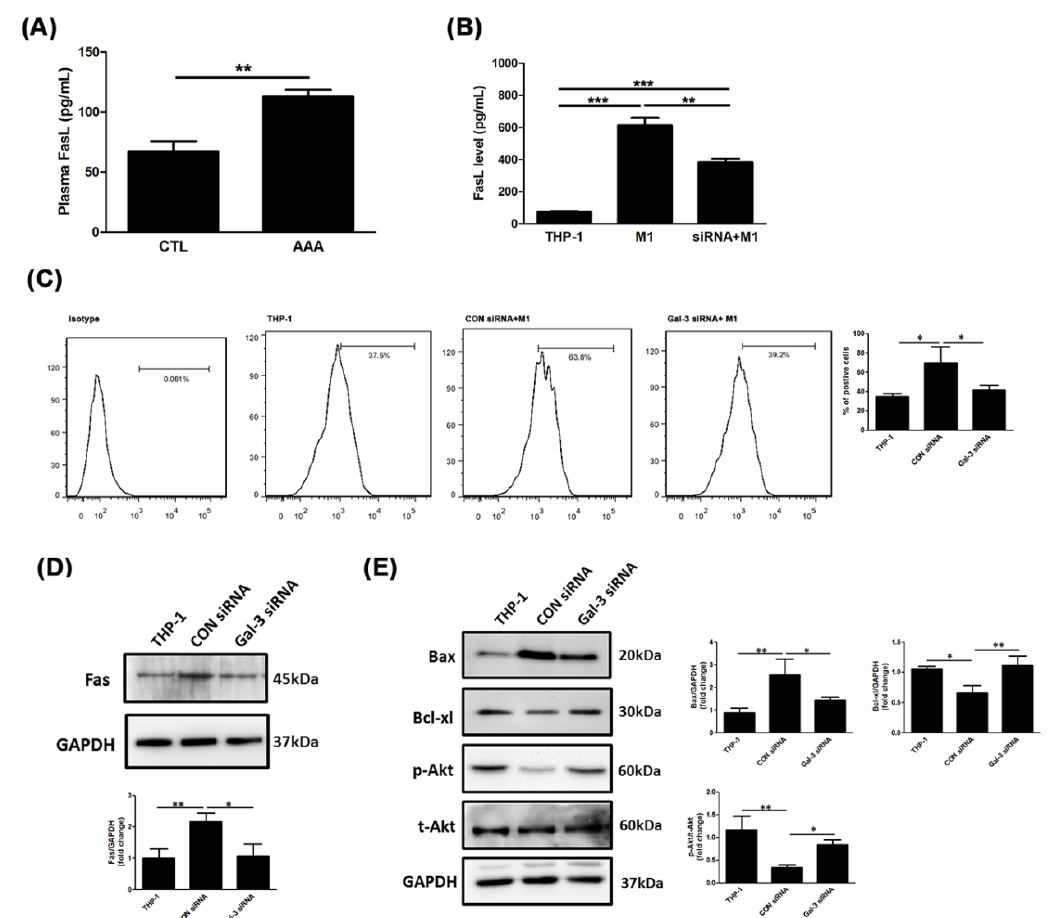
Figure 5. Gal-3 blockade attenuated macrophage-induced SMC apoptosis by Fas deactivation. ( A , B ) Comparison of soluble FasL level in human plasma and CM. Data are expressed as mean ± S.E.M. * p < 0.05, ** p < 0.001, *** p < 0.0001. ( C ) Expression of Fas a surface death receptor on A7R5 cells was evaluated using flow cytometry analysis. All experiments were repeated independently in triplicate. ( D , E ) Expression levels of Fas, Bax, and Bcl-xl and phosphorylation of Akt and total Akt were analyzed through Western blots analysis; GAPDH was used as a loading control. All experiments were repeated independently in triplicate.